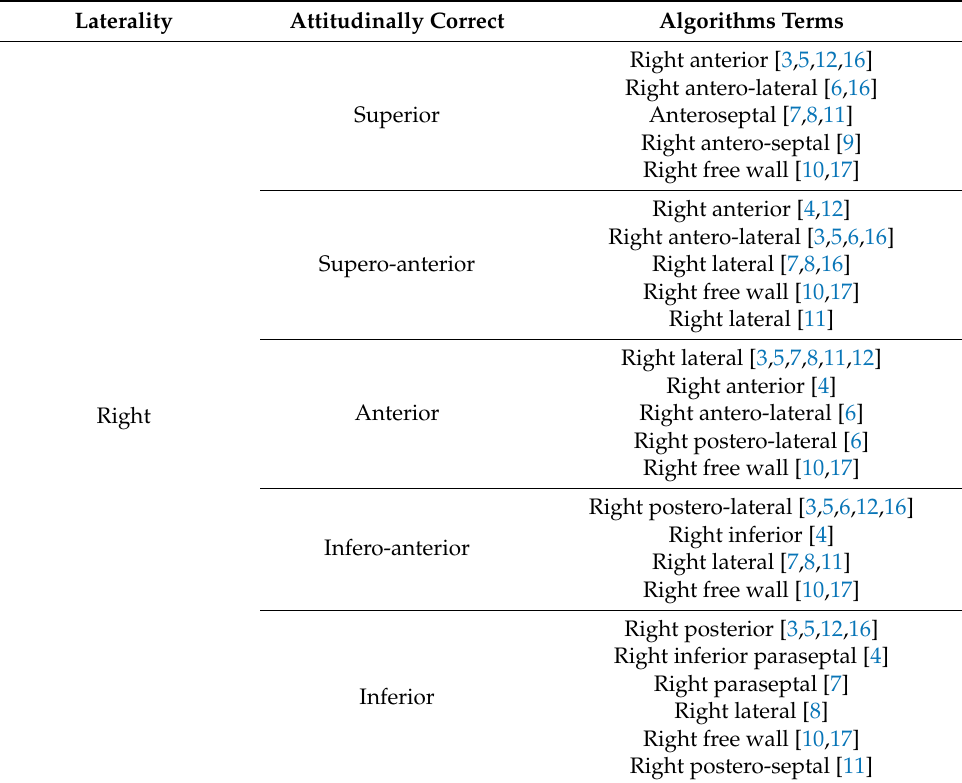
Table 1. Description of accessory pathway locations from the consensus statement from the Cardiac Nomenclature Study Group, the Working Group of Arrhythmias, the European Society of Cardiology, and the Task Force on Cardiac Nomenclature from NASPE [18] and the studied